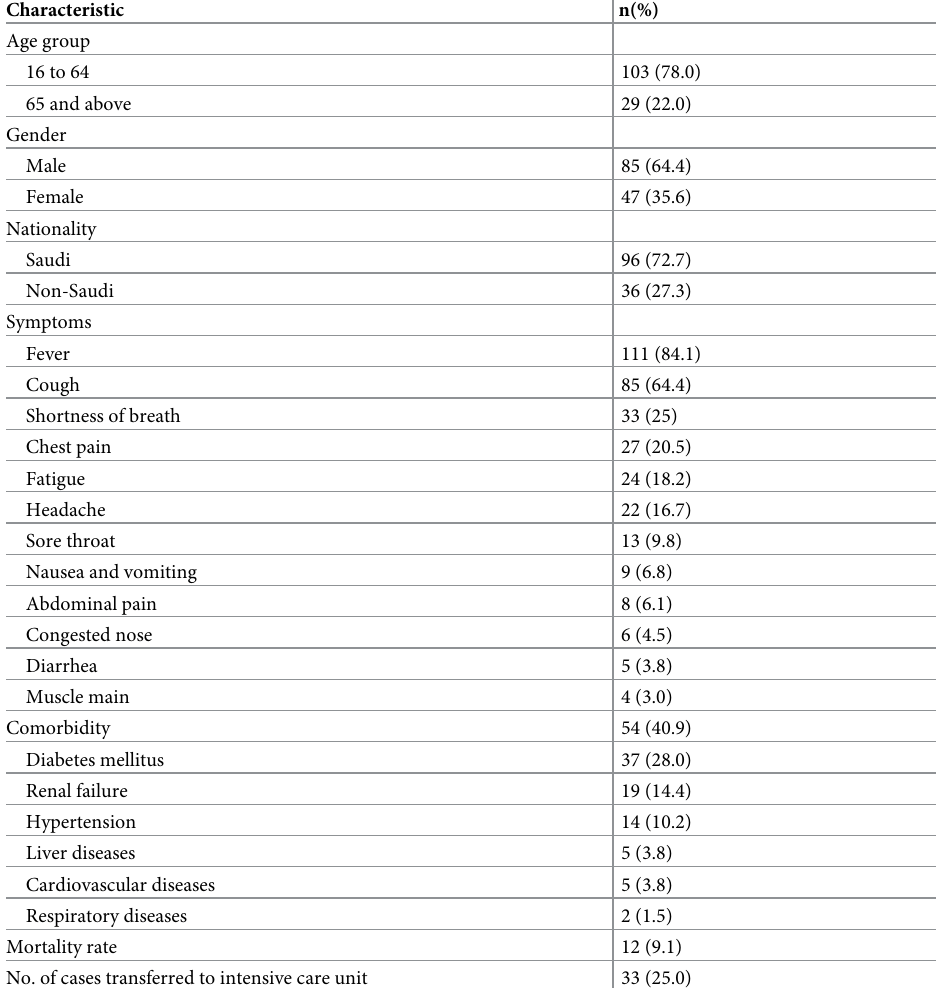
Table 1. Baseline characteristic of patients with COVID-19